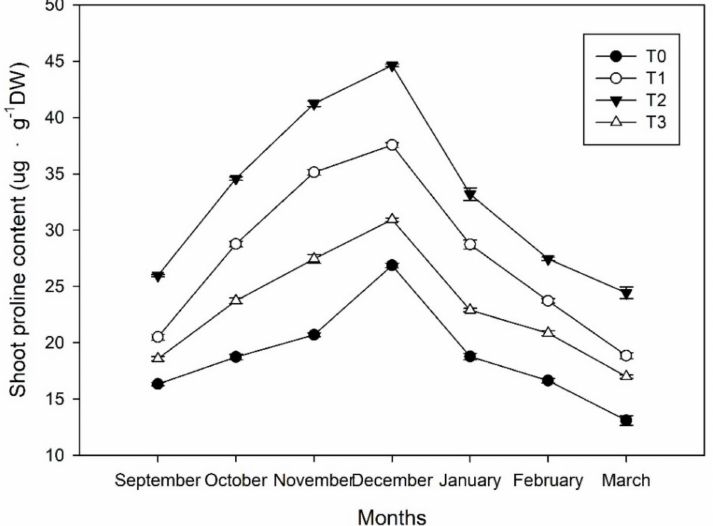
Figure 8. Dynamics of the proline content of shoots in Magnolia wufengensis under ethephon (ETH) treatments.